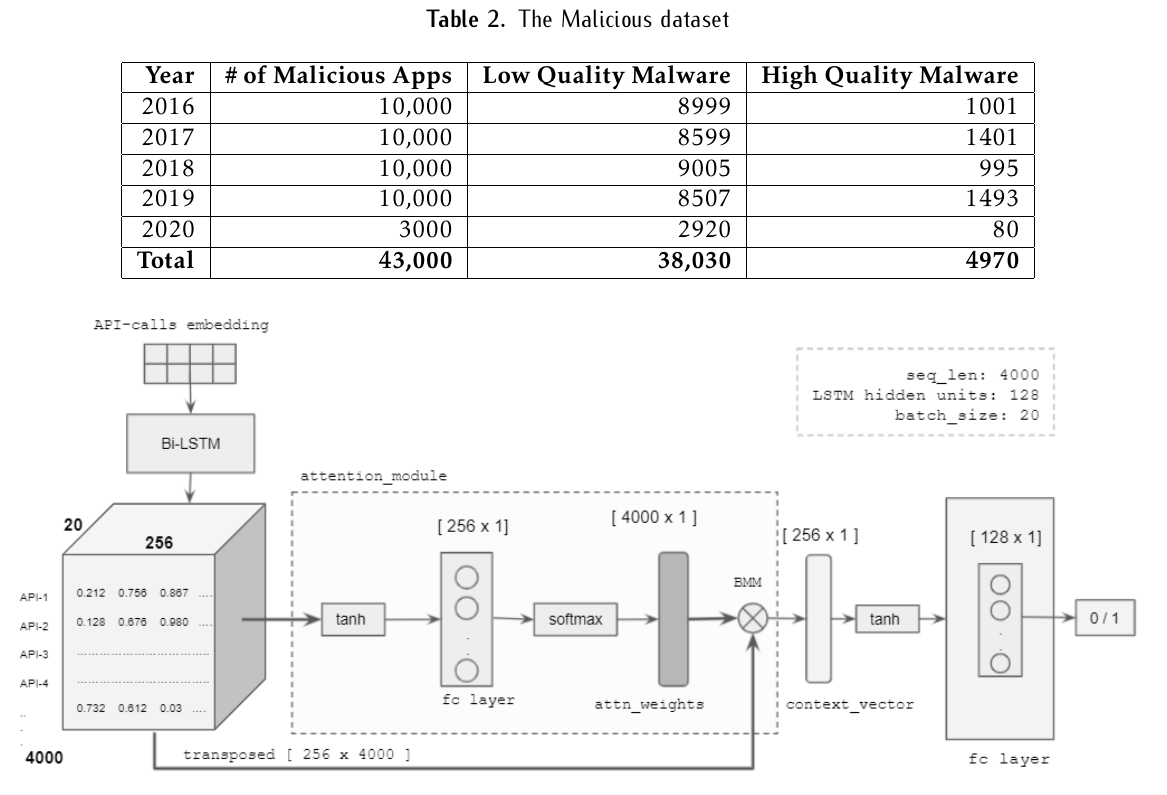
Figure 5. Detailed Bi-LSTM